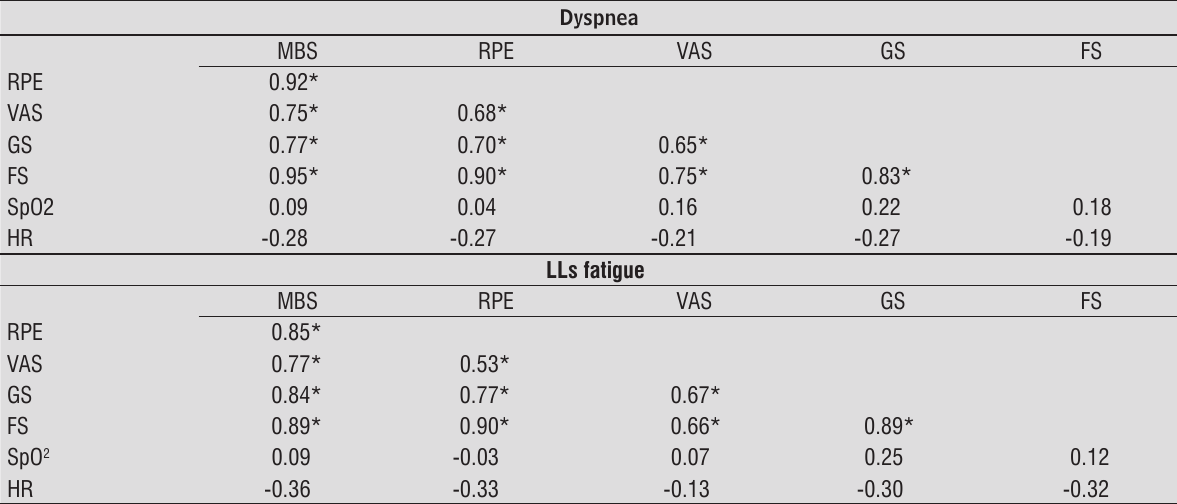
Table 4 - Spearman correlation coefficient between the five adopted patient - reported scales, peripheral oxygen